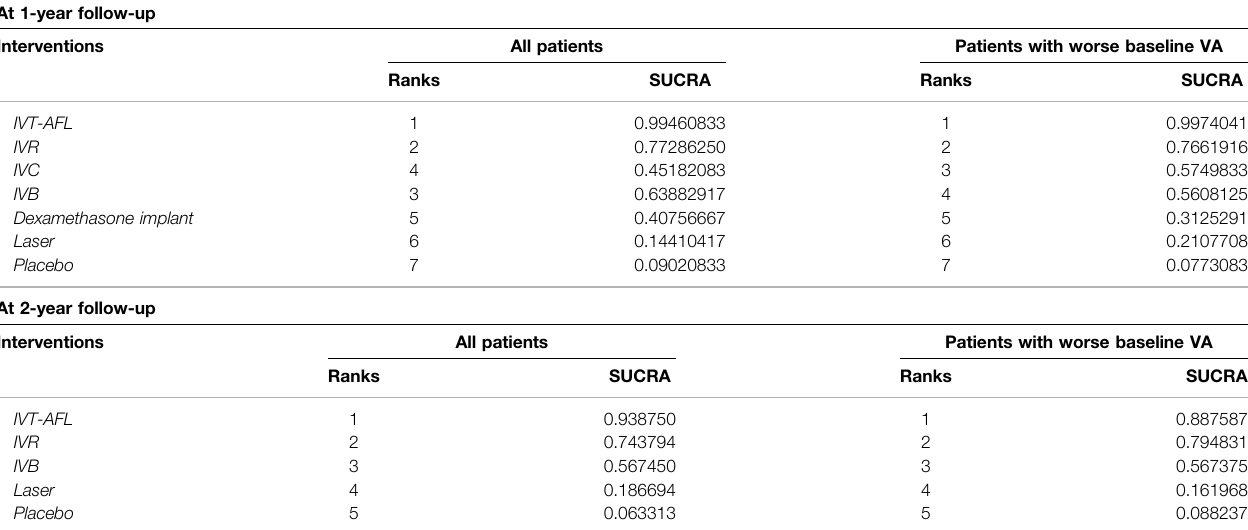
TABLE 4 | Ranking probabilities for all interventions for the proportion of patients with a gain of at least 15 ETDRS letters. At 1-year